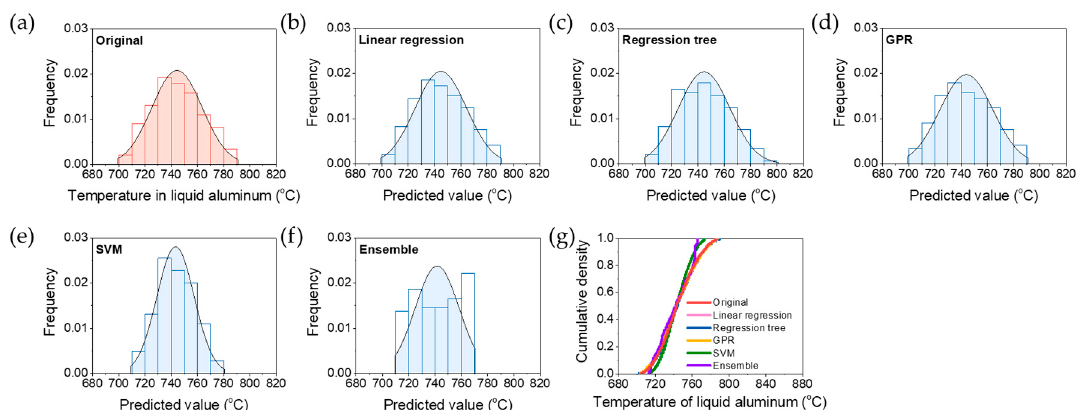
Figure 4. Data distribution of temperature of liquid aluminum from ( a ) new experiment for prediction and predicted value by different machine learning (ML) models of ( b ) linear regression, ( c ) regression tree, ( d ) GPR, ( e ) SVM and ( f ) ensemble regression trees. The colored area in each graph of ( a – f ) (red, or blue) describes corresponding probability density function for the data distribution. ( g ) The corresponding cumulative density function for predicted values from each ML model compared to the histogram of the experimental value of temperature of liquid aluminum.